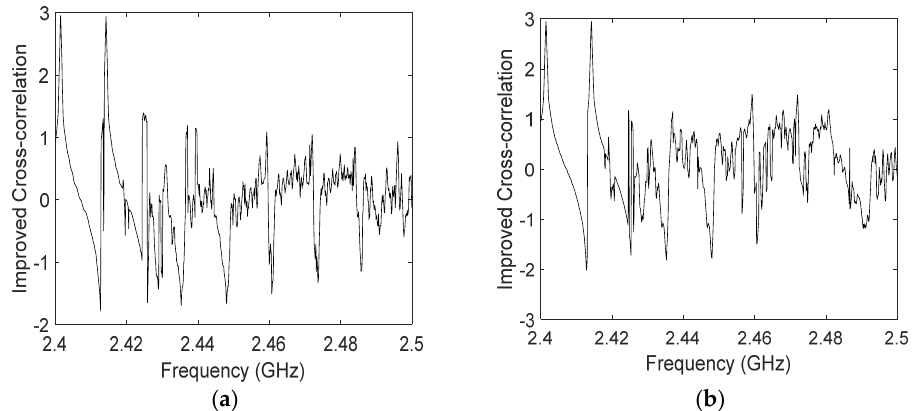
Figure 20. The frequency estimation using the proposed method indoors at distances of ( a ) 5 m and ( b ) 10 m.